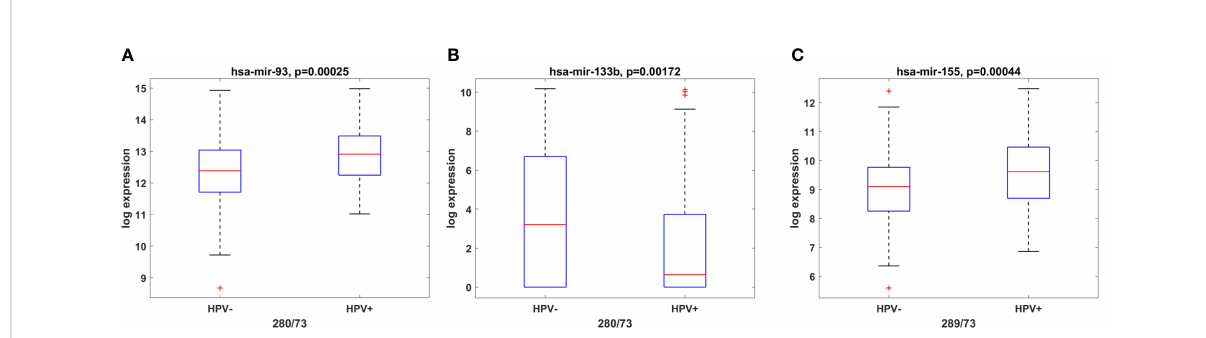
FIGURE 3 miR-93-5p, miR-133b and miR-155-5p have HPV-dependent expression. Box plots showing the expression levels of miR-93-5p (A) , miR-133b (B) and miR-155-5p (C) in both OSCC HPV+ and HPV- OSCC tissues from the TCGA cohort. P ≤ 0.05 was considered statistically signi fi cant for all